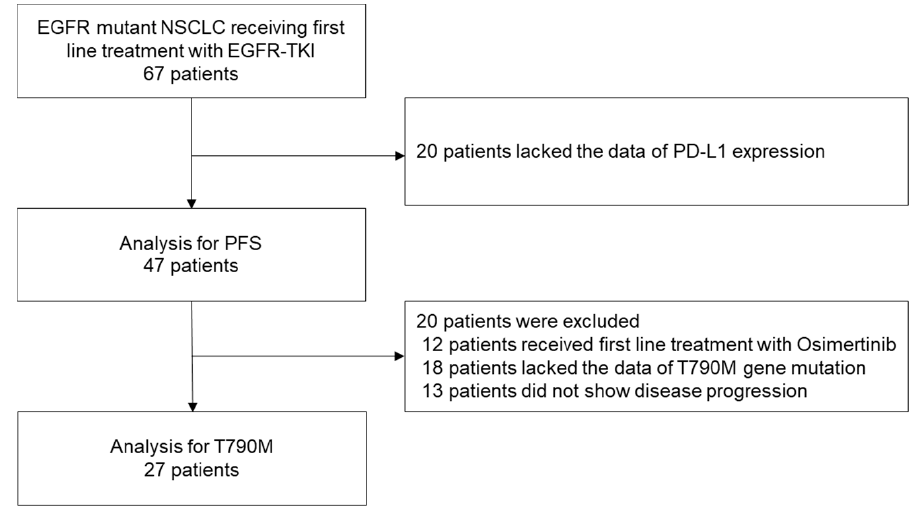
Figure 1. Patient selection. Of the data of 67 patients with EGFR-mutant NSCLC who had received first-line treatment with EGFR-TKIs, those of 47 patients were analyzed to determine the PFS and